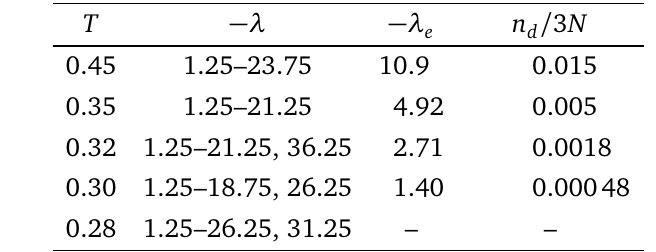
Table 1: Range of eigenvalues used to compute the average in Eq. (7), mobility edge λ , and fraction of the delocalized unstable modes n e temperatures. Note that a few isolated eigenvalues are included in the averages at T = 0.28,0.39,0.32.